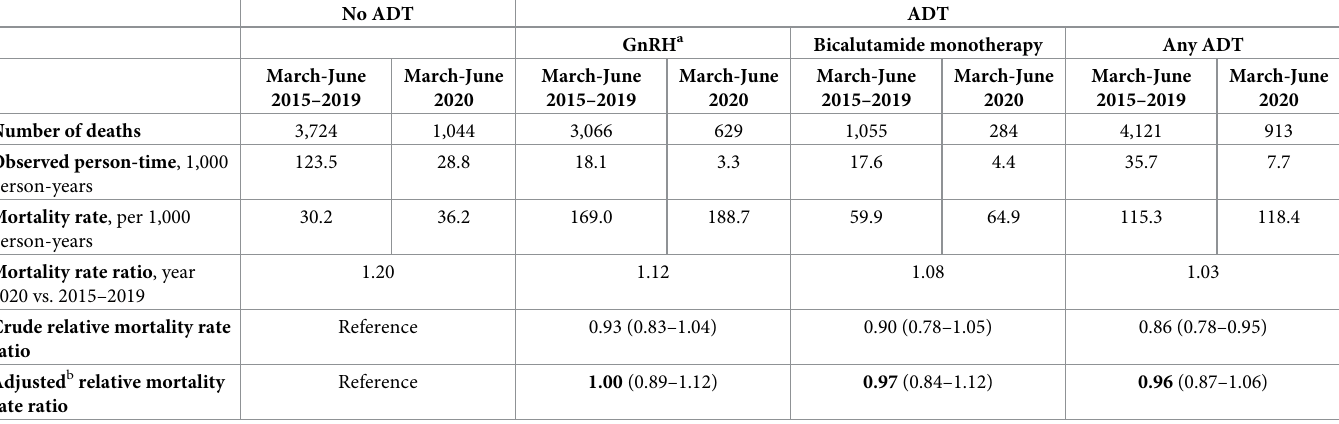
Table 2. Association between exposure to GnRH agonists, bicalutamide monotherapy, or any androgen deprivation therapy (ADT) and all-cause mortality in men with prostate cancer in PCBaSe RAPID